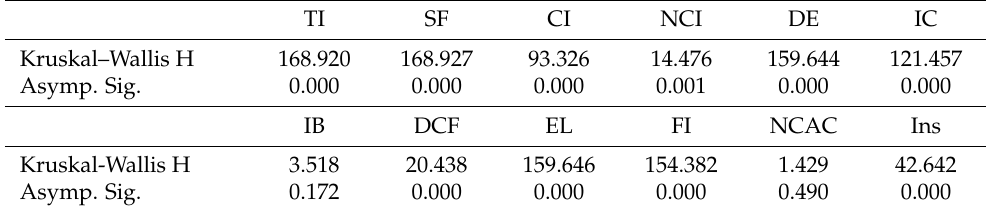
Table 6. The output of the Kruskal–Wallis test (legal form).